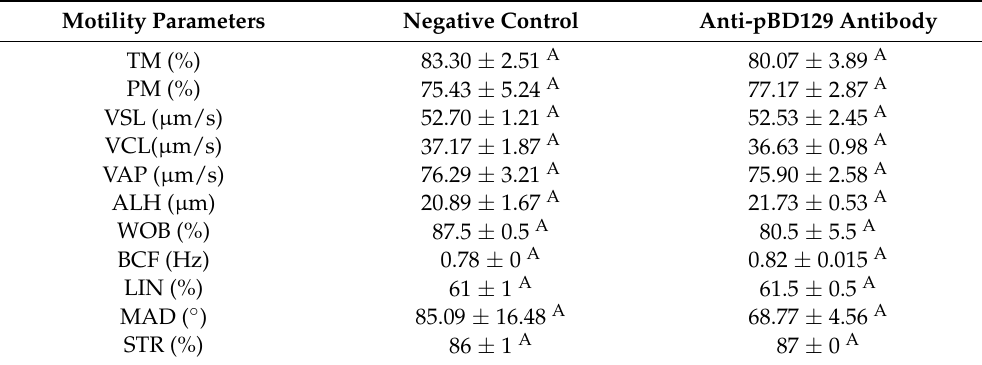
Table 1. Sperm motility parameter correlation analyses of negative control and anti-pBD129 antibody- treated spermatozoa.